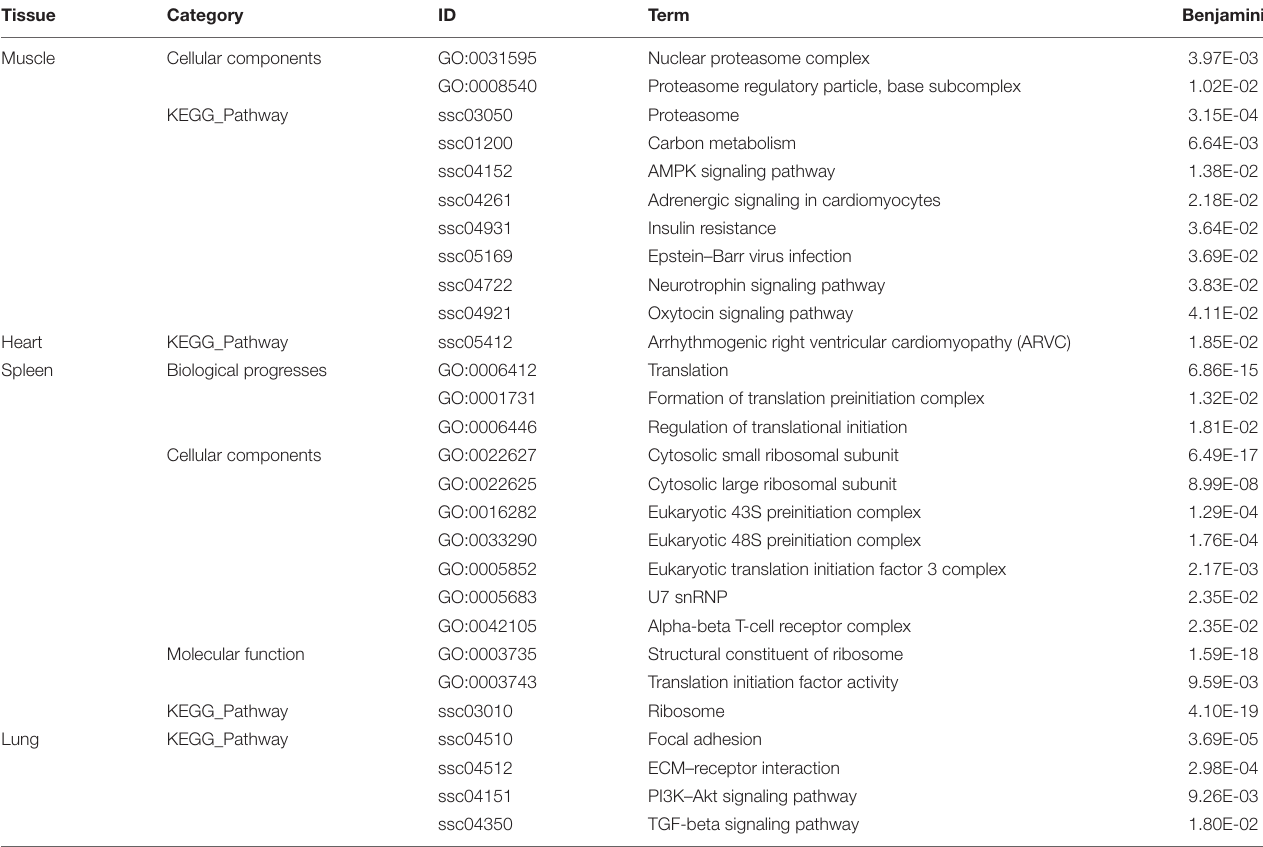
TABLE 2 | Pathways that are only significantly enriched in Tibetan pig tissue modules.